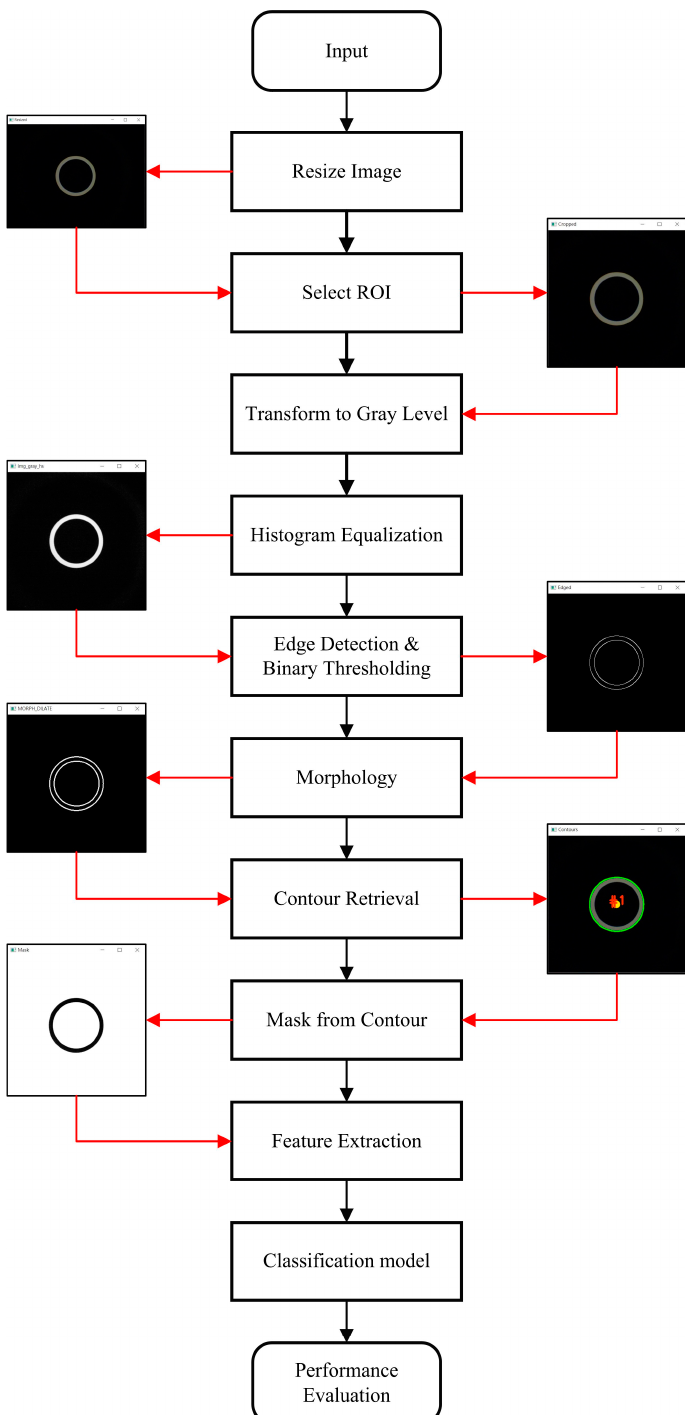
Figure 8. Flow chart of image processing algorithm.